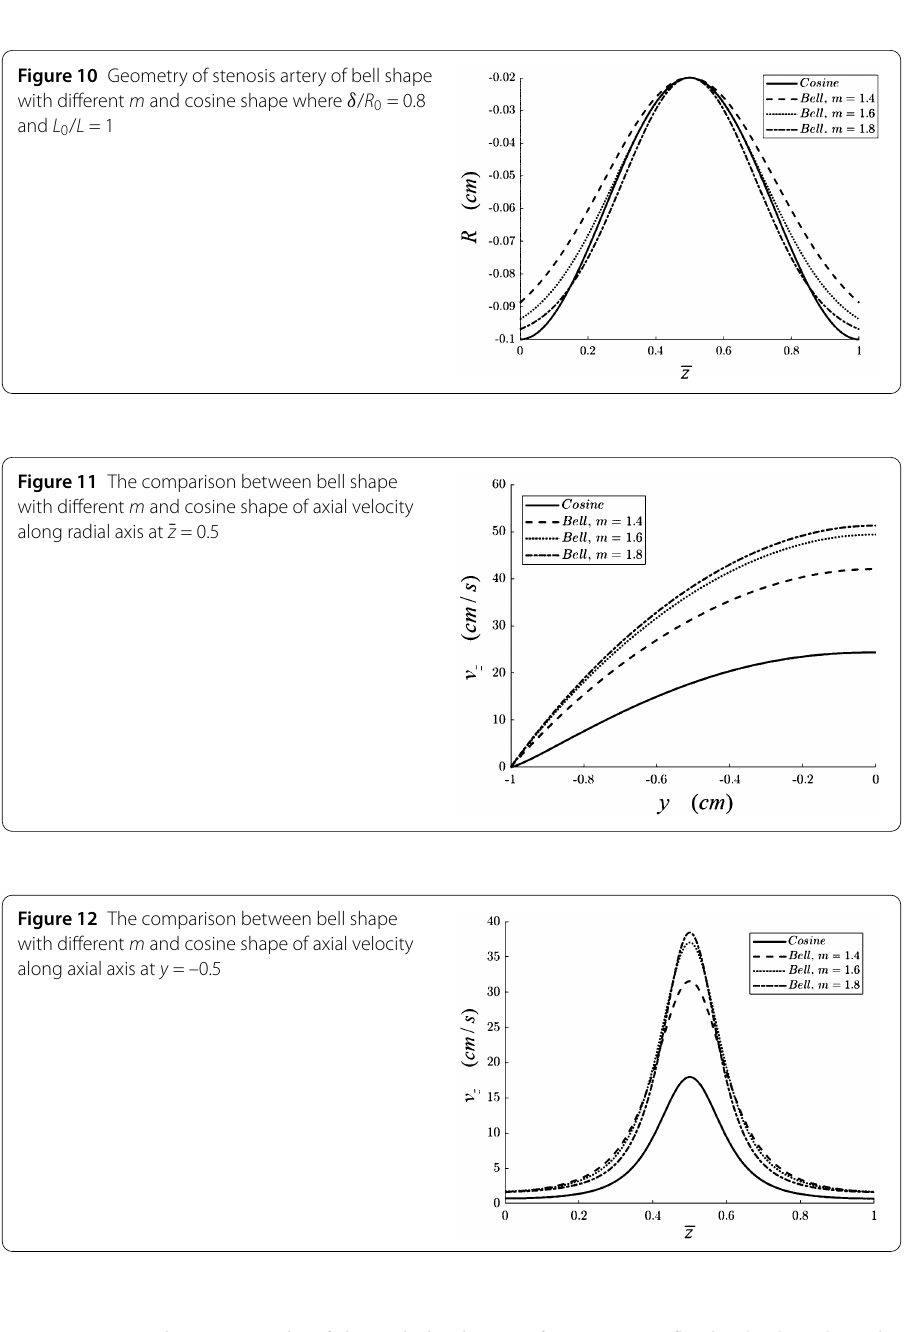
Figure 10 Geometry of stenosis artery of bell shape with different m and cosine shape where δ / R 0 = 0.8 and L 0 / L = 1